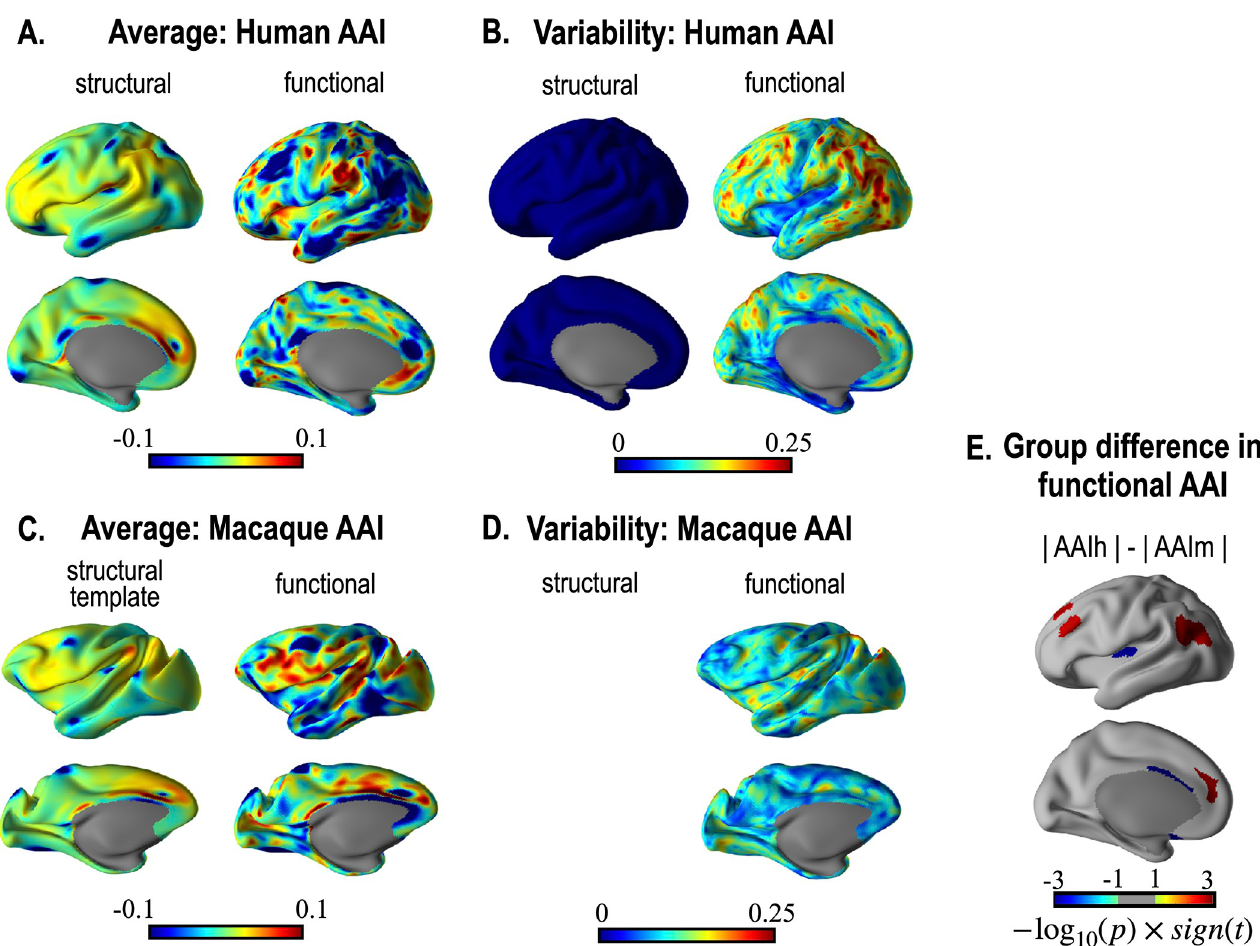
Fig 8. Group interhemispheric asymmetry results: Humans and macaques (13 each). A and B show mean and standard deviation of AAI evaluated after registration of the right hemisphere to the left hemisphere in humans using structural features (left column) and using combined (structural and functional) features (right column) were computed on each parcellation. C and D show the results of the macaque’s interhemispheric registration using structural and functional features. E displays two-sample t-test result of the absolute value of human AAI and macaque AAI with intensity = − log 10 p � sign ( t ).